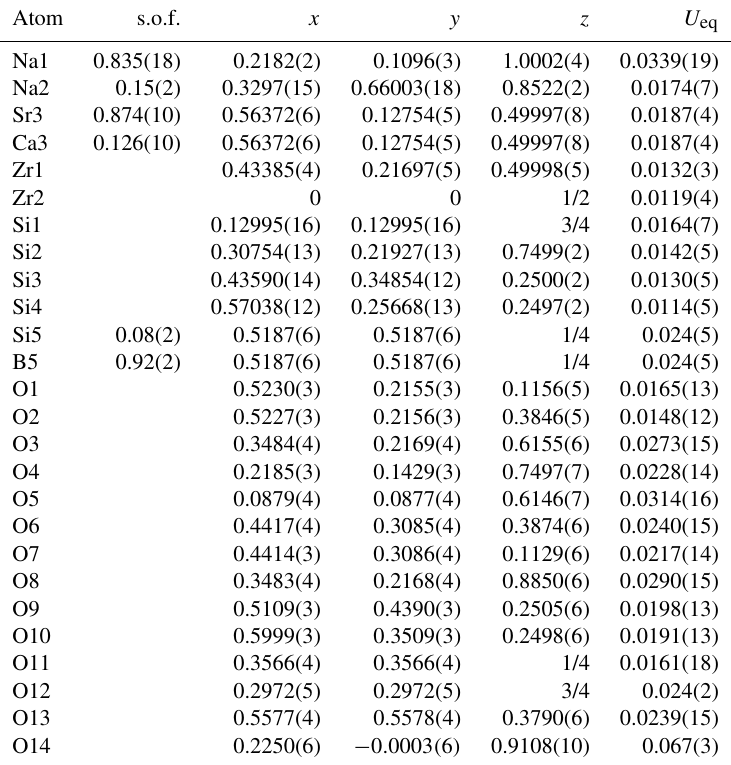
Table 3. Atomic coordinates and isotropic displacement parameters (in Å 2 ) for bobtraillite.